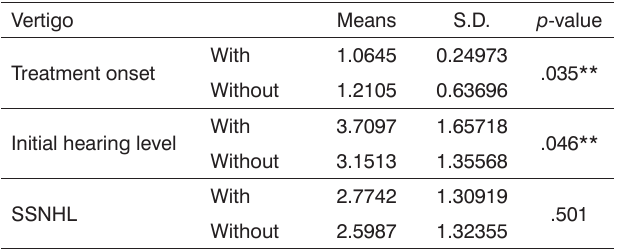
Table 2. Results of comparison between with vertigo and without vertigo.